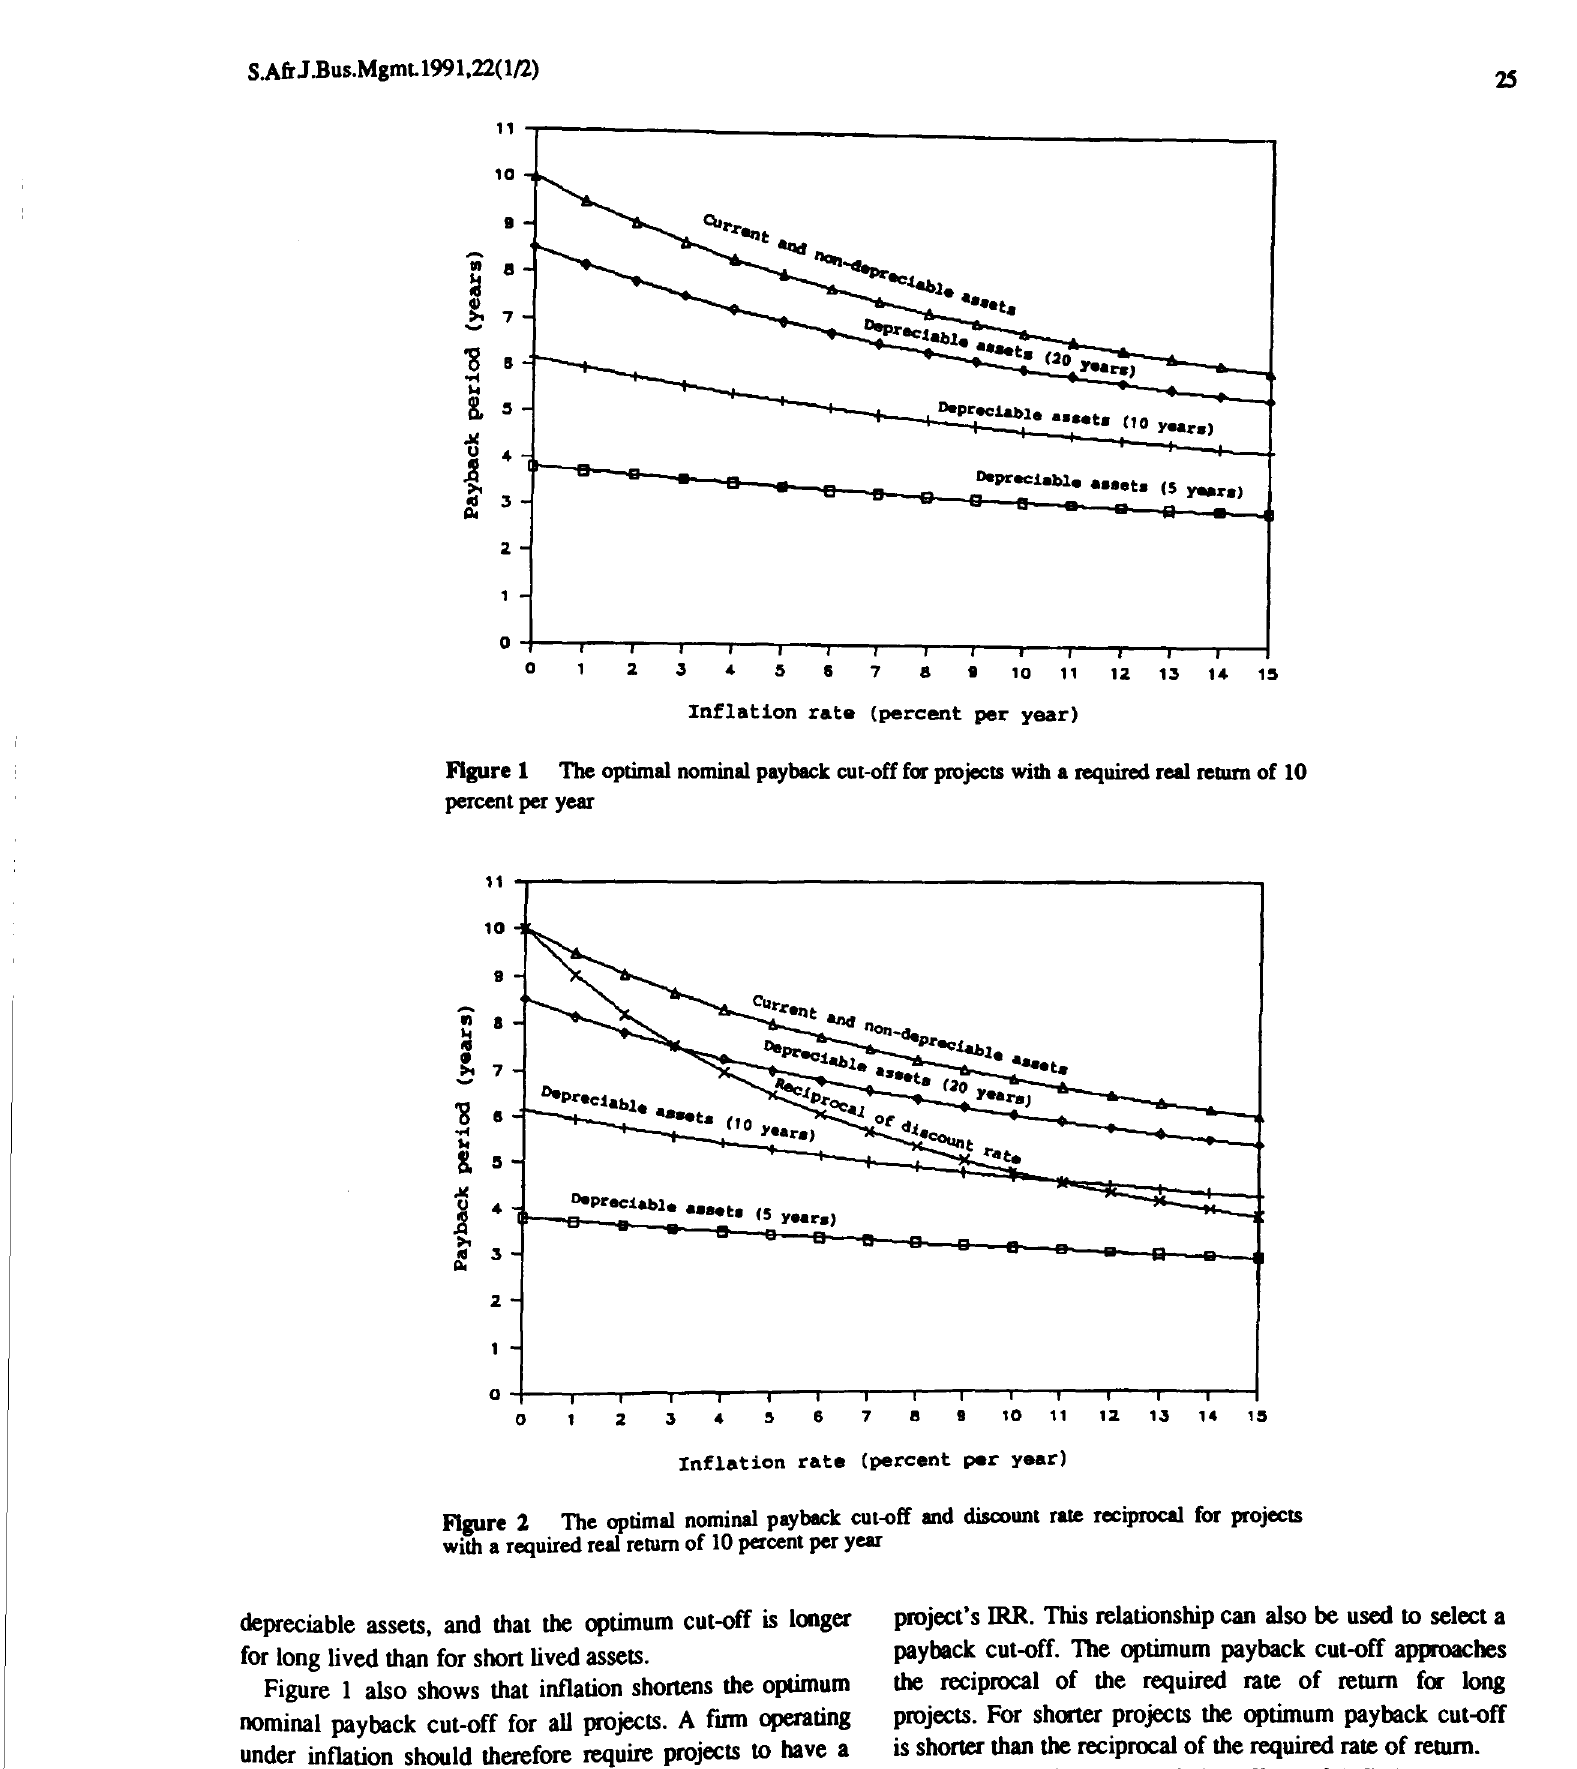
Figure 2 The optimal nominal payback cut-off and discount rate reciprocal for projects with a required real return of 10 percent per